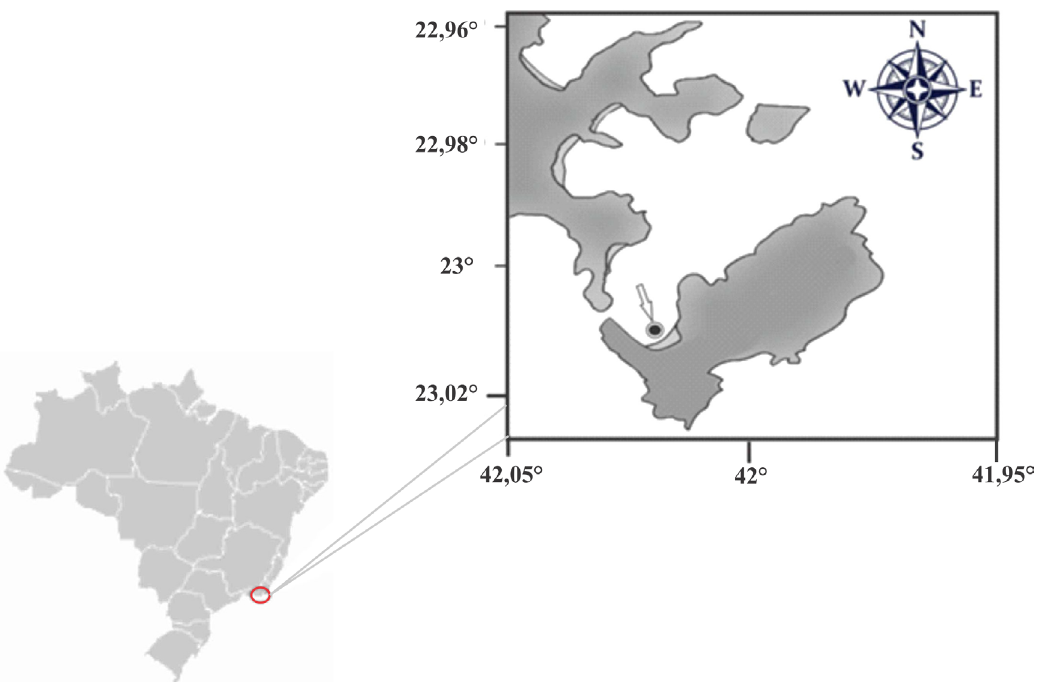
Figure 1. Map of the geographic location of Arraial do Cabo, state of Rio de Janeiro,